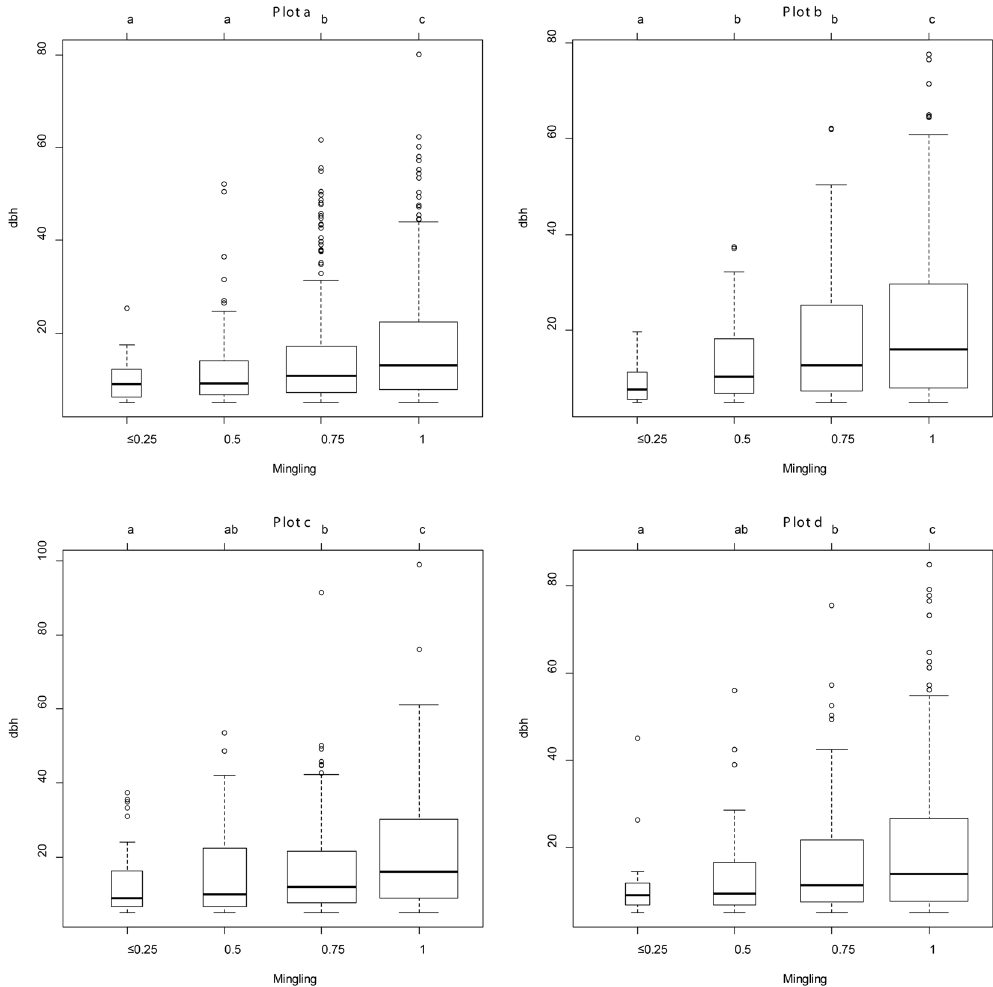
Figure 1. Differences of tree sizes at different mingling levels. Different letters denote significant differences ( p < 0.05) in dbh values when the neighbourhood species mingling levels varied. The four nearest-neighbour trees of an individual tree were used to construct the mingling index. If a reference tree had no or only one heterospecific neighbor, the mingling level was 0 or 0.25. If all four neighbors were heterospecific, the mingling level was 1 (high mingling). Trees of mingling levels 0 and 0.25 were grouped into a single